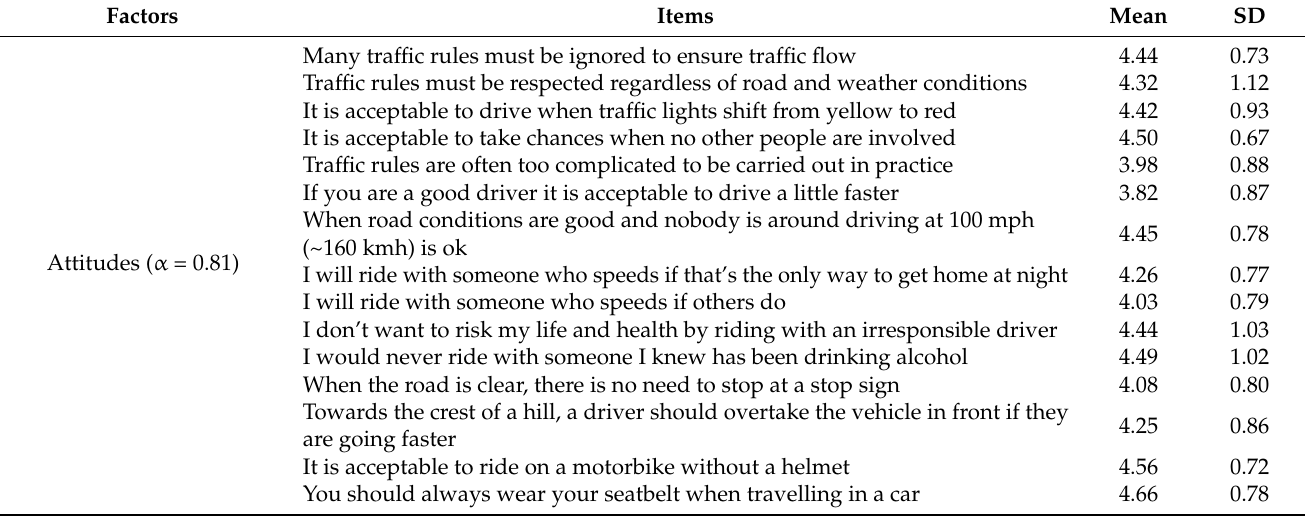
Table 2. The alpha values, means and standard deviations for attitudes towards road safety.